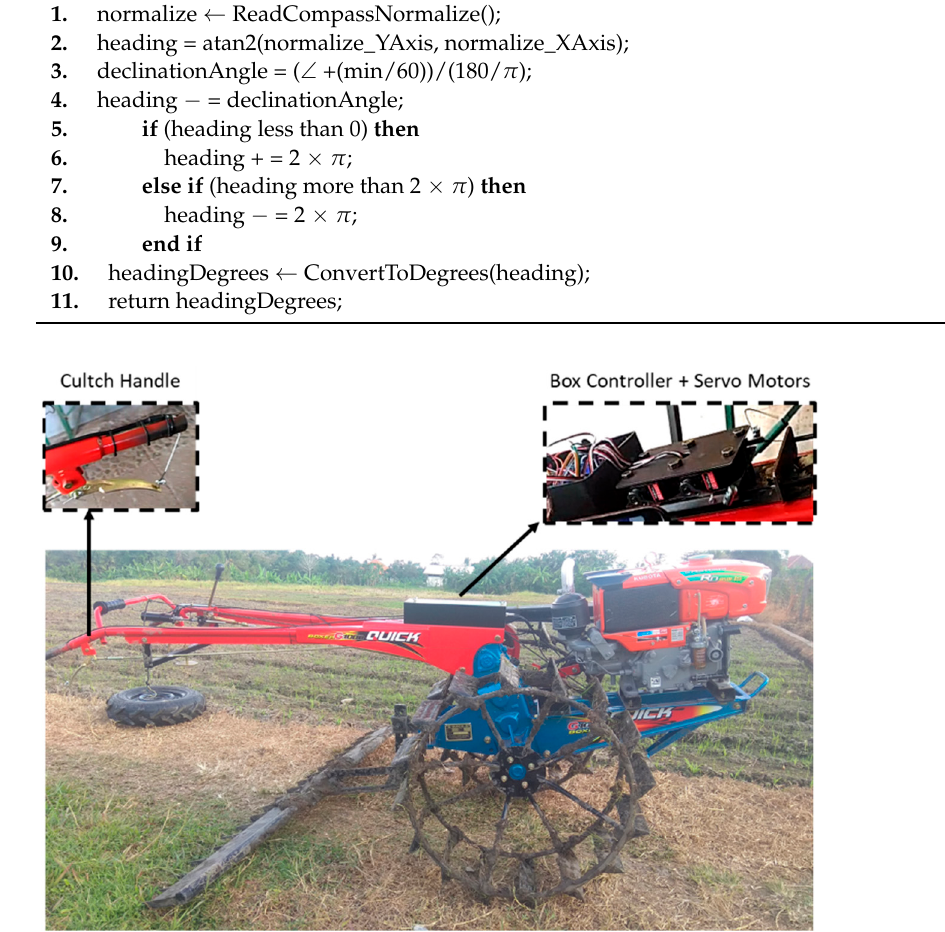
Figure 8. Path planning platform implementation using Laravel and Google Maps.